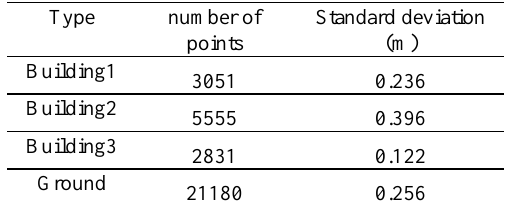
Figure 7. a) Generated DSM using the proposed method, b) DSM of PCI